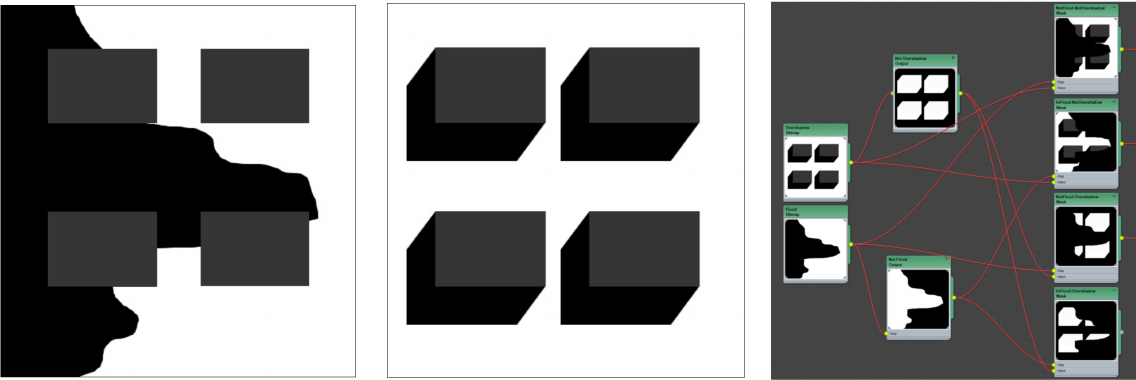
Figure 6. Screengrab showing an indicative intersection detail with four buildings (in grey) and flood map (black); MIDDLE shows the winter building overshadowing map at 12:00 (shade in black); RIGHT shows how these maps are brought together to generate four ‘presence–absence’ conditions maps. Image by authors using Autodesk™ Slate Editor.